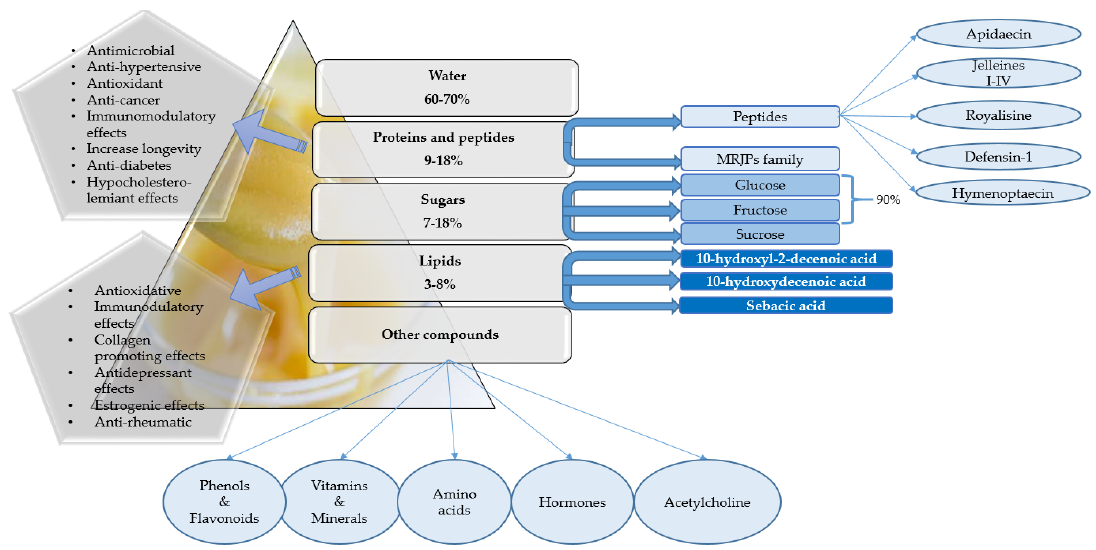
Figure 2. Schematical representation of the biological composition of royal jelly and the main functional activities of the compounds [37–43] .